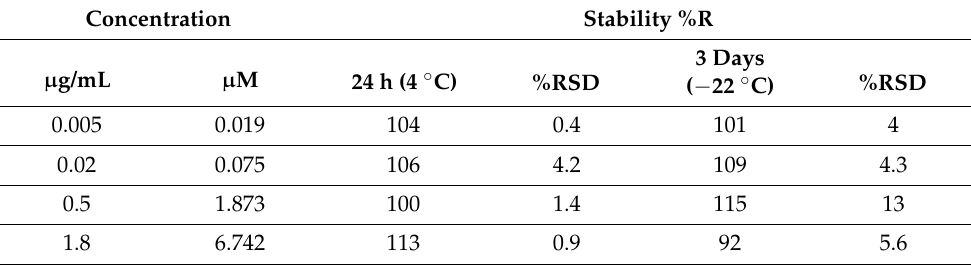
Table 3. Stability data of adenosine at four concentration levels. Analysis was performed in triplicates, and mean recovery (%) was assessed as the percentage concentration of that determined at t0, when samples were freshly